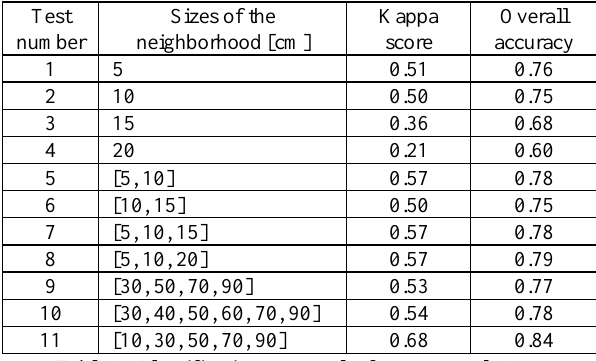
Table 1. Classification test results for test sample 1